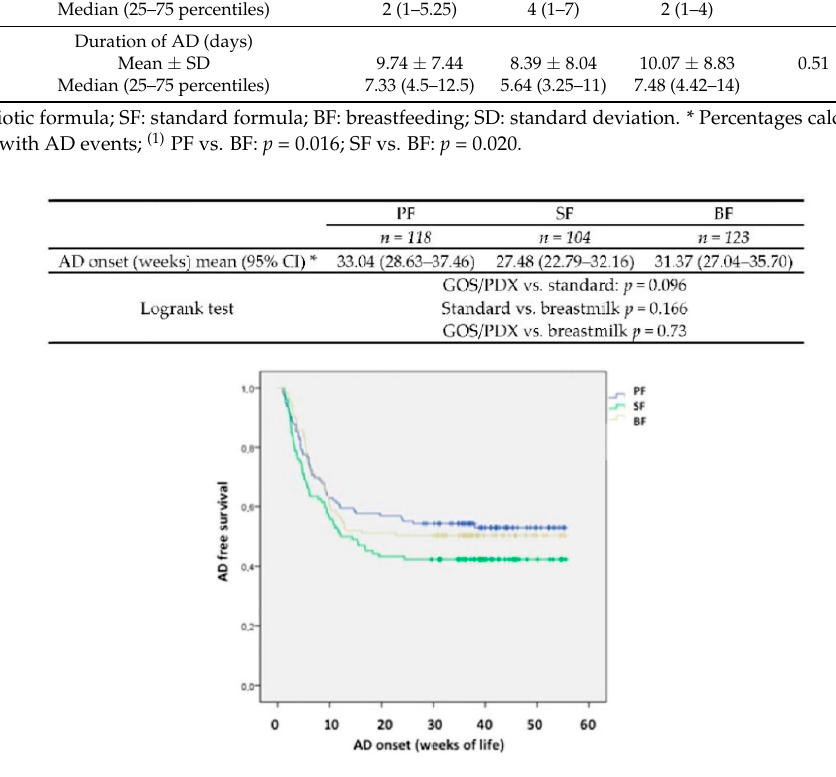
Figure 2. Atopic dermatitis onset according to type of feeding. AD: atopic dermatitis; PF: prebiotic formula; SF: stan. Table 3. Cox analysis to estimate AD risk considering potential covariates (hazard ratios and 95% CIs for the incidence of AD).